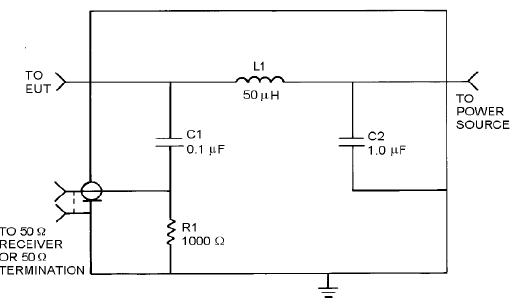
Figure 10. Schematic of LISN for tests in the frequency range (0.15 – 30) MHz [29].